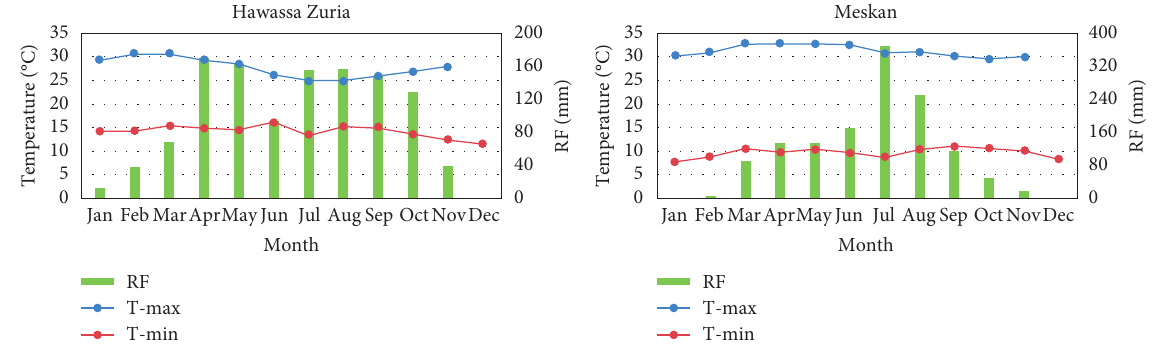
Figure 1: Monthly average temperature and annual rainfall of the study areas (2019 and 2020). RF: rainfall; T-min and T-max: minimum and maximum temperatures,